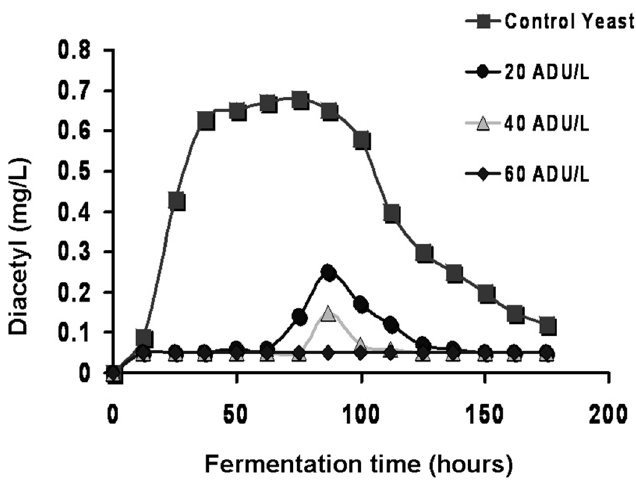
Fermentation 2017 , 3 , 63